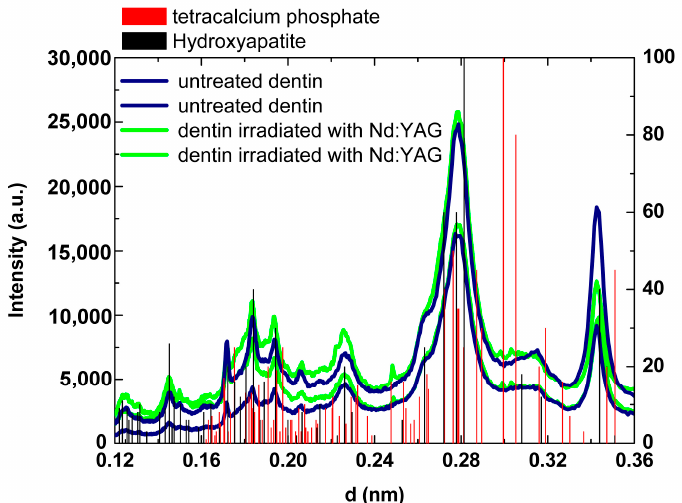
Figure 3. X-ray diffraction pattern of two samples of untreated and two samples of Nd:YAG laser irradiated dentin. The main Bragg peaks expected for hydroxyapatite (HAP; JCPDF 09-0432) and for tetracalcium phosphate (TetCP, JCPDF 25-1137) are indicated in black and red, respectively. The morphological changes promoted by treatments are observed in Figure 5. On untreated slabs there is a flat surface, which is covered by a smear layer and without the exposition of dentin tubules. The APF application promoted the removal of this smear layer, the exposition of the opened dentin tubules, and the formation of some globules among dentin tubules. Root dentin irradiated with Nd:YAG laser showed irregularities and depressions, characteristics of melting of the surface, with zones of fusion and ressolidification in a mosaic pattern. The association of APF and Nd:YAG